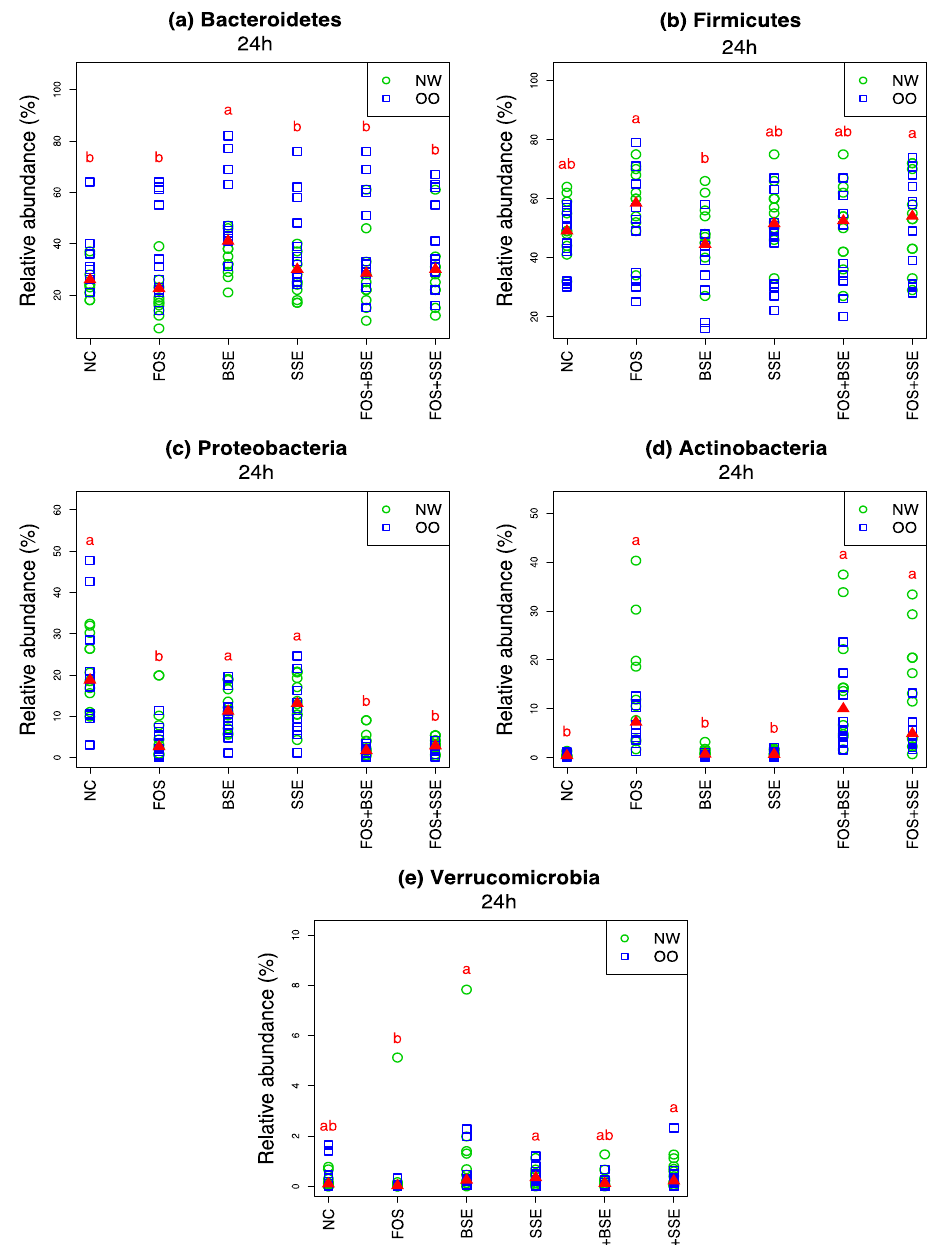
Figure 4. Relative abundance at phylum level ( n = 22). ( a ) Bacteroidetes, ( b ) Firmicutes, ( c ) Proteobacteria, ( d ) Actinobacteria, ( e ) Verrucomicrobia. Letters indicate significant differences between treatments at 24 h, achieved by the Friedman test and its post hoc multiple comparisons at the 0.05 level of significance. The medians are marked with red triangles. The weight classes (NW vs. OO) are labeled by green circles and blue squares, respectively. NC: negative control, FOS: fructooligosaccharides, BSE: black sorghum bran extract, SSE: sumac sorghum bran extract. NW tended to display a greater response of Actinobacteria than OO in FOS, FOS + BSE and FOS